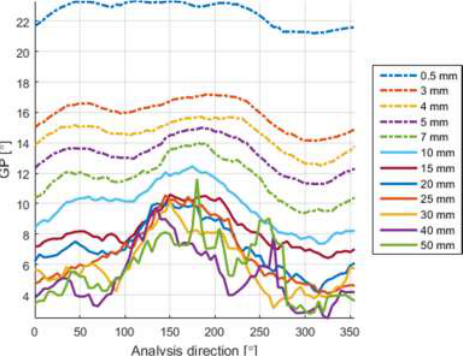
Figure 3. Changes of the noise effect with analysis direction for the noisy 5 mm grids. Reference surface and original grid of 5 mm are added for comparison.